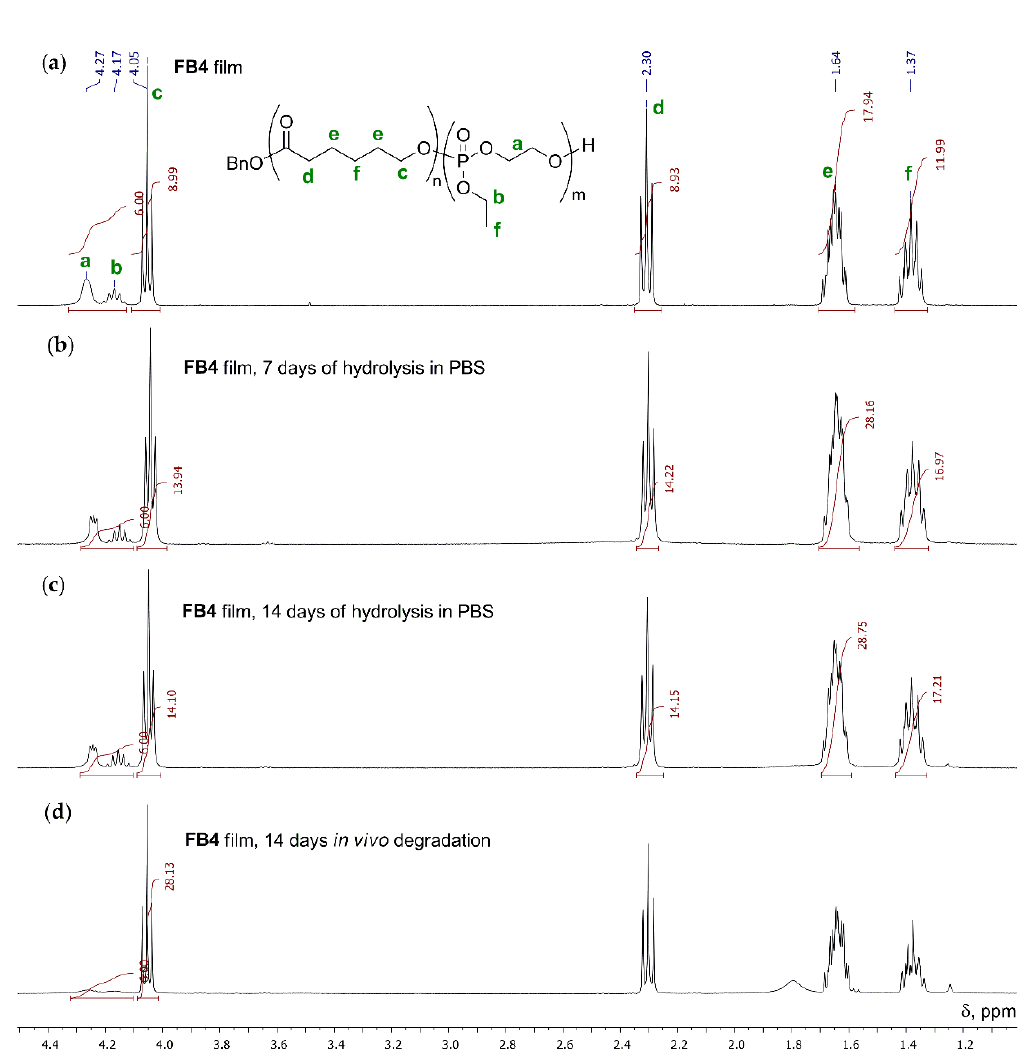
Figure 3. SEM images of the surfaces of polymer film FB4 before ( a ) and after ( b ) 14 day hydrolysis in PBS.